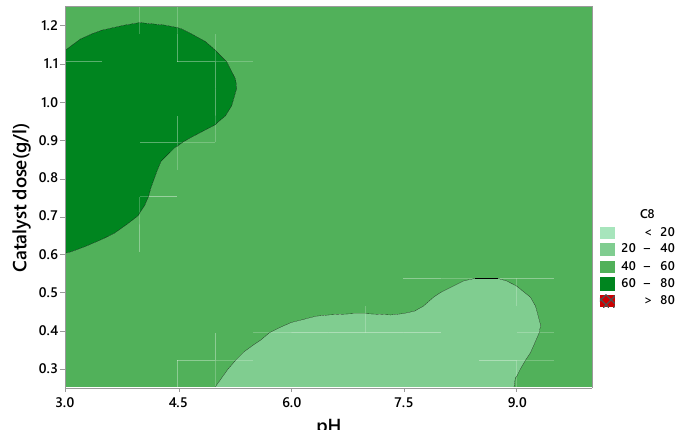
Fig. 6. Effect of pH on degradation of Acid Red 18 using TiO